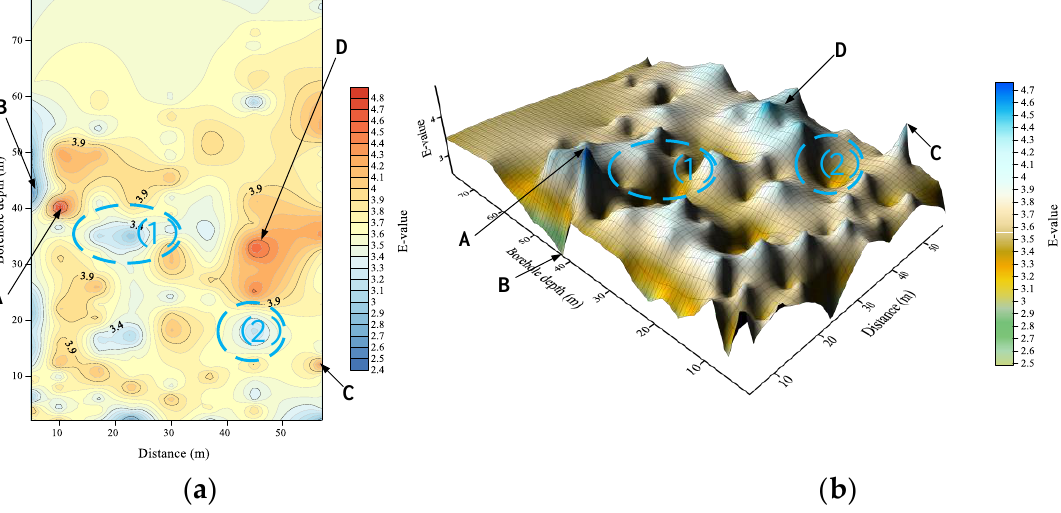
Figure 12. Grouting-efficiency assessment result based on the comprehensive evaluation model: ( a ) Contour map of grouting efficiency and ( b ) 3-D cloud map of grouting efficiency.